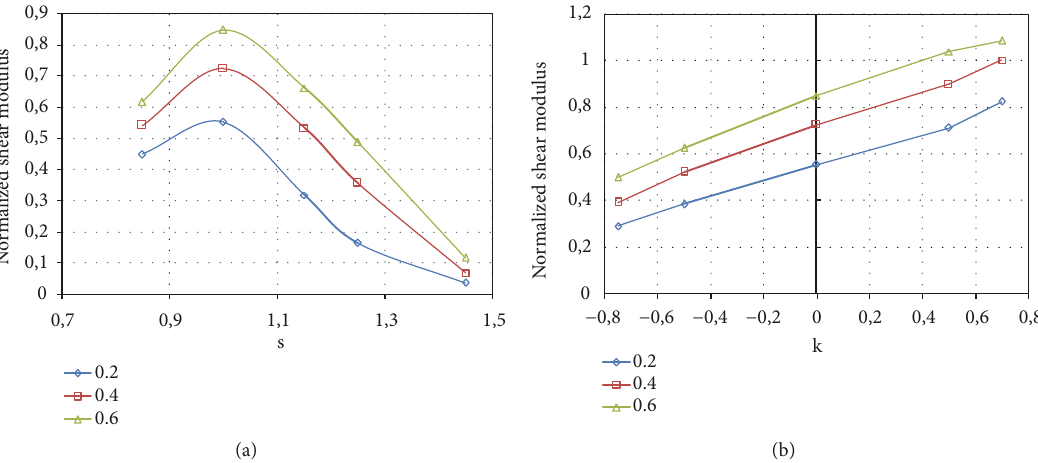
Figure 22: Normalized shear modulus: (a) solid P-cells with variable s parameter ( 𝑘 = 0 ); (b) solid P-cells with variable 𝑘 parameter ( 𝑠 = 1 ).